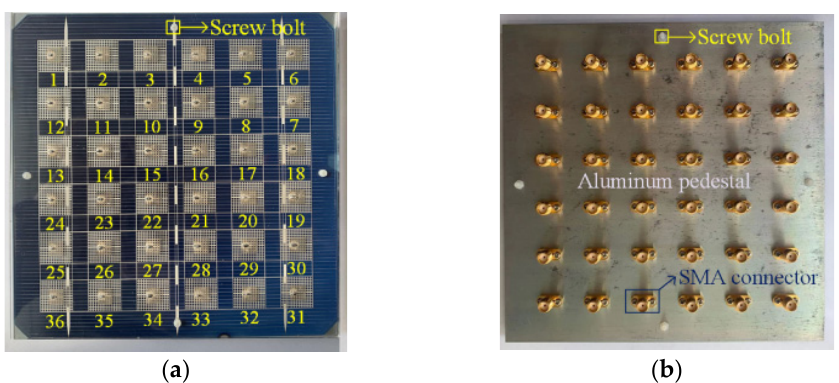
Figure 29. Proposed antenna integrated with solar cell: ( a ) top view; ( b ) bottom view [122].